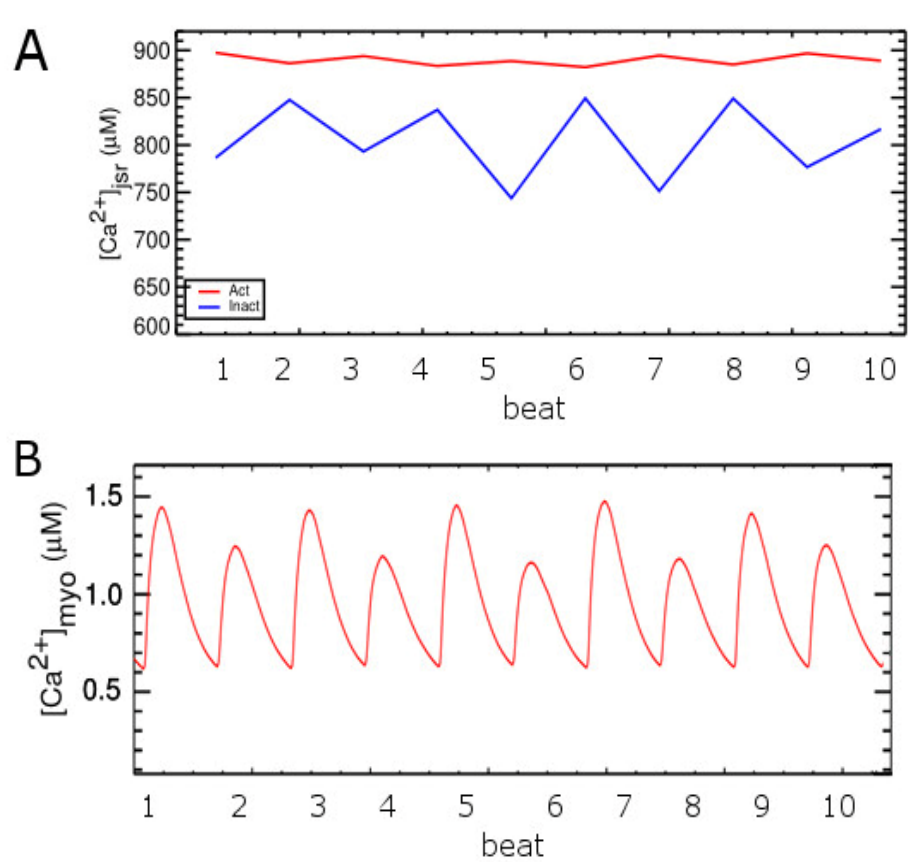
Figure 10. 8 Hz pacing with [Na + ] i = 15 mM: ( A ) The average of [Ca 2+ ] jSR right before the stimulus from CRUs in two groups: red = Act, blue = Inactivate, and the nadir value. ( B ) Alternans in the myoplasmic calcium transient.